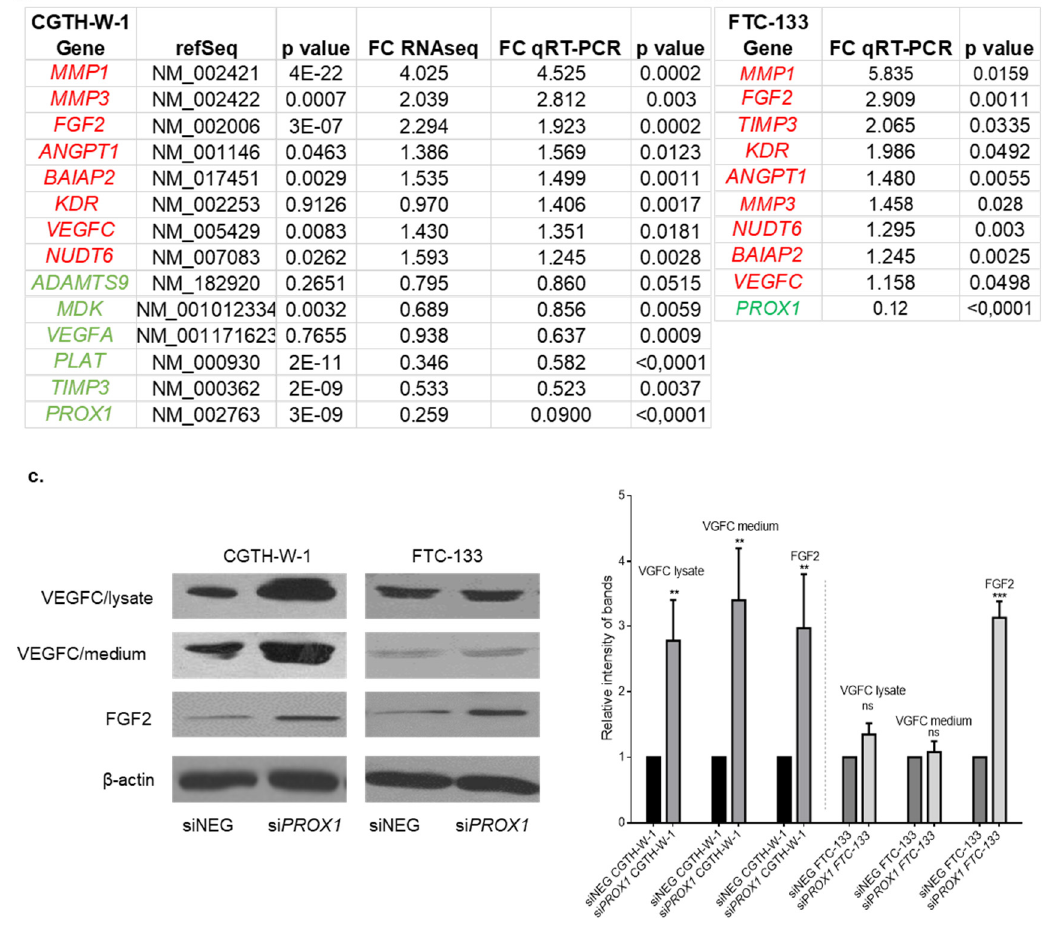
Figure 1. The knockdown of Prospero homeobox 1 gene PROX1 in CGTH-W-1 and FTC-133 resulted in expression changes of factors involved in angiogenesis. ( a ) The genes involved in the regulation of angiogenesis are significantly regulated under PROX1 -knockdown in the CGTH-W-1 cell line. The tables show the ID gene (RefSeq), fold changes and p values detected in RNAseq analysis, as well as by RT-qPCR technique (the red color indicates up-regulated genes and the green color indicates down-regulated genes). ( b ) Expression levels of selected genes were estimated in FTC-133 cells after silencing of PROX1 using RT-qPCR. All presented RT-qPCR data represent average of the values obtained from silencing with two si PROX1 (SA and SC). ( c ) Western blotting was performed on cell lysate and medium collected after 72 h from CGTH-W-1 and FTC-133 cells treated with si PROX1 or control universal negative siRNA (siNEG). Representative images show the results of Western blotting analysis using the anti-VEGFC (vascular endothelial growth factor C) and anti-FGF2 (fibroblast growth factor 2) primary antibodies; β -actin served as an internal loading control. VEGFC and FGF2 in cell lysates and VEGFC in medium were ~3–4× (** p < 0.01) higher after silencing in comparison to control. In FTC-133 cells PROX1 -knockdown had a negligible effect on VEGFC levels, whereas FGF-2 was ~3.5× (*** p < 0.001) increased in FTC-133-si PROX1 . Signals of Western blotting (WB) were measured using ImageJ and the relative band intensities are shown on the graph. The presented WB intensity data are averages of signals obtained with two si PROX1 (SA and SC). To investigate the pro-angiogenic effect of factors secreted to the medium upon PROX1 silencing, we performed the tube formation assay with human umbilical endothelial cells (HUVECs) using si PROX1 (SA) (Figure 2a,b) or si PROX1 (SC) (Figure S2). HUVECs were incubated on Matrigel-coated plates in conditioned medium collected from cancer cells with PROX1-silenced or control cells treated with siNEG. In applied experimental setup, HUVECs revealed the behavior of endothelial cells influenced by regulators secreted from tumoral cells. In particular, tubule formation